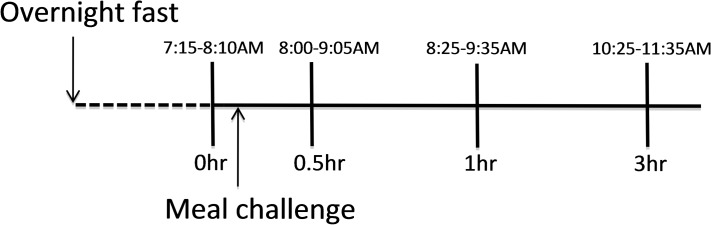
The study design.After an overnight fast, blood was collected and thereafter the challenge meal was consumed. Postprandial blood collection was done at 0.5, 1, and 3 h after finished meal. The meal challenge was repeated at six occasions in total. Hour of blood collection varied between experiments, illustrated by time spans.